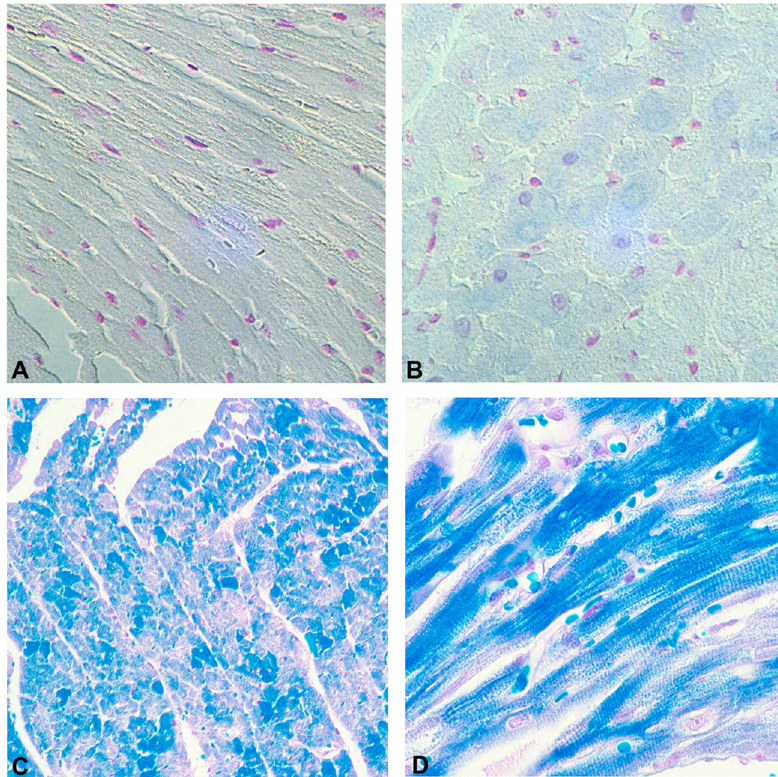
Figure 7. Luxol Fast Blue histochemical assessment of cardiomyocyte myofilament lysis. Luxol Fast Blue staining for the analysis of cardiomyocyte myofilament integrity was performed in left ventricular free walls from 12 month old WT (panel A), 12 month old NTT-MMP-2 transgenic mice (panel B) and 12 month old hearts expressing the full length MMP-2 cDNA (panels C and D). Myofilament lysis results in Luxol Fast Blue staining. There is little Luxol Fast Blue staining in the 12 month old WT or NTT-MMP transgenic hearts while there is abundant Luxol Fast Blue staining in the 12 month old full-length MMP-2 transgenic